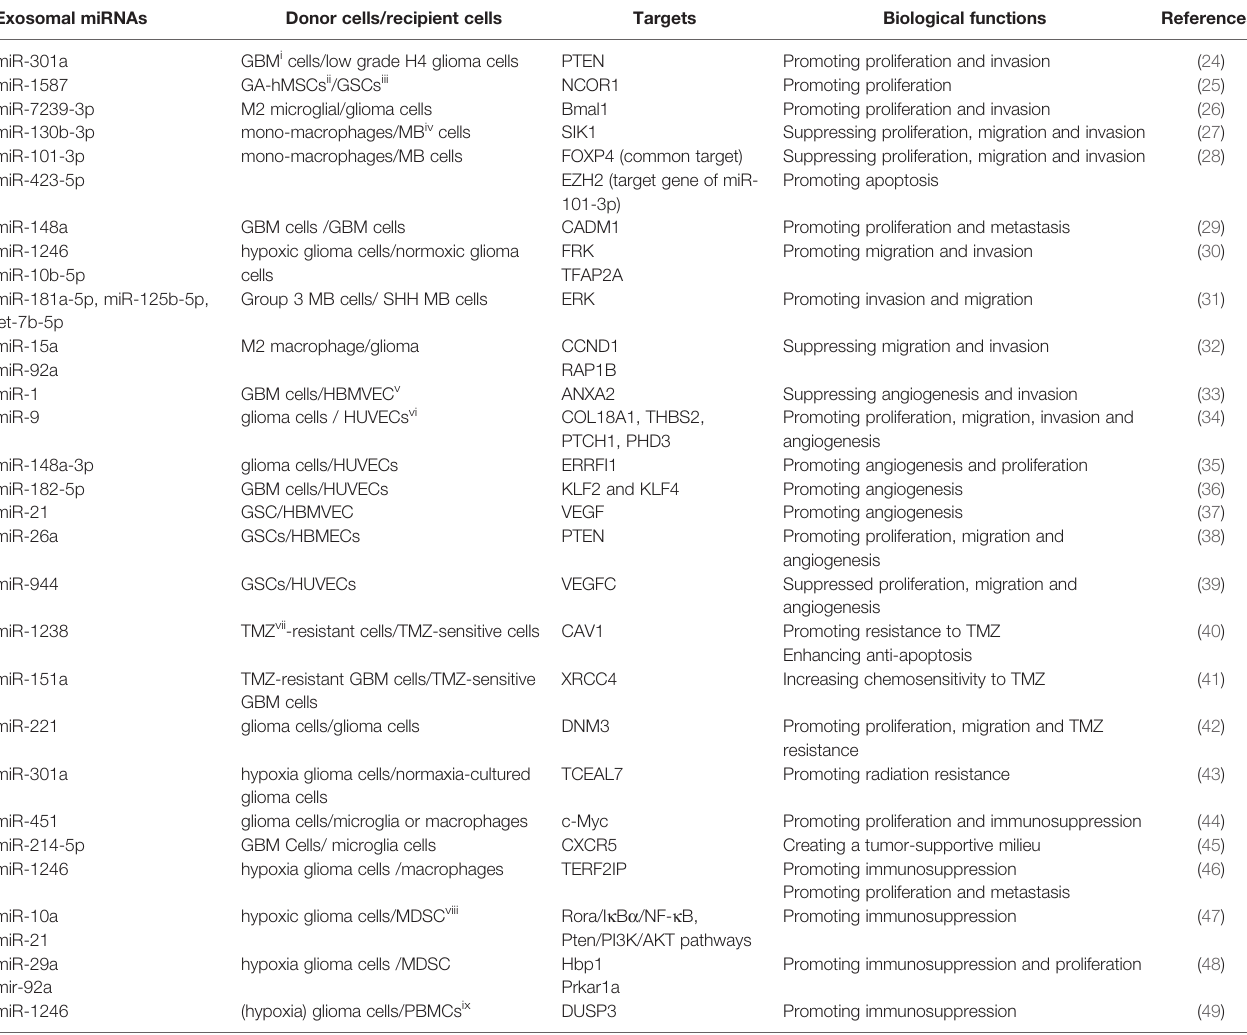
TABLE 1 | The biological roles of exosomal miRNAs in glioma biology. Exosomal